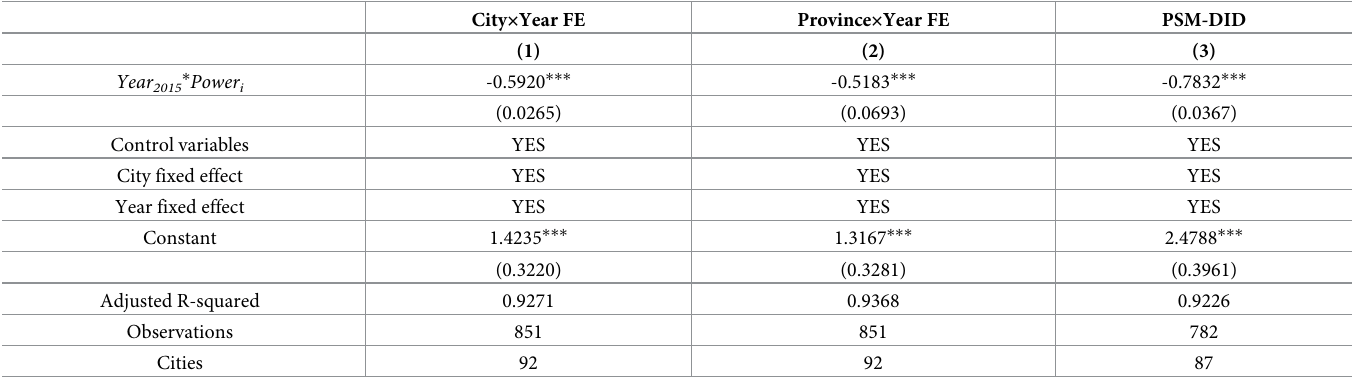
Table 6. Alternative